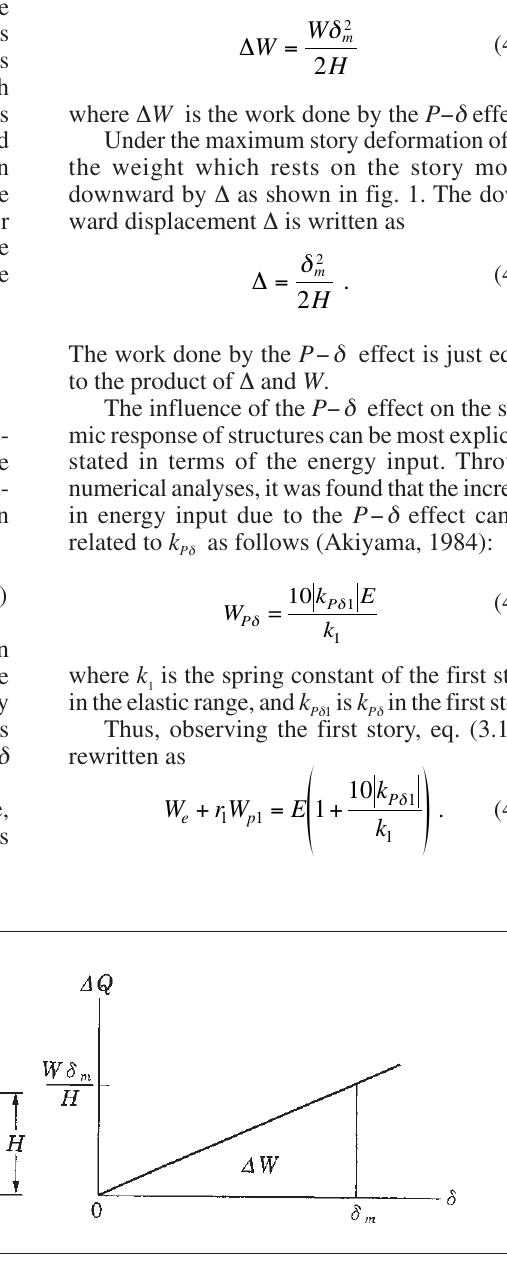
Fig. 2. P (cid:60)(cid:98)